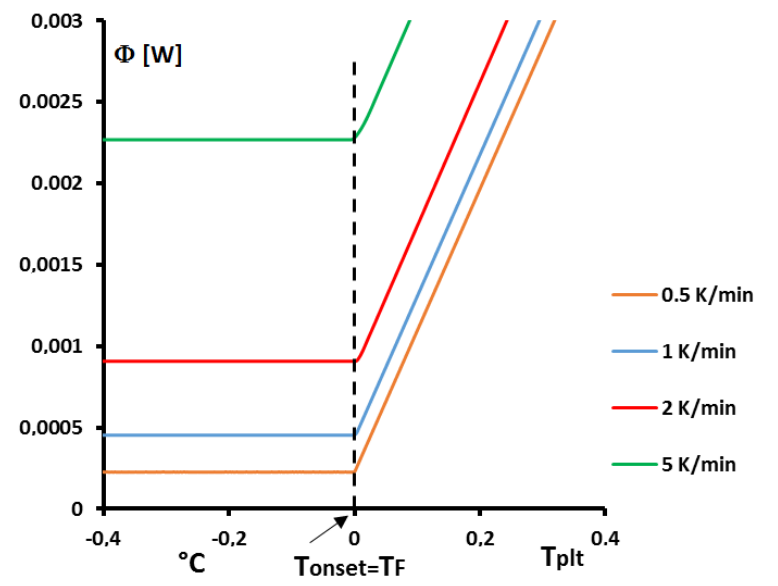
Figure 14. Drawing for the determination of T onset = T F in case of a calibration of the temperature different at each heating